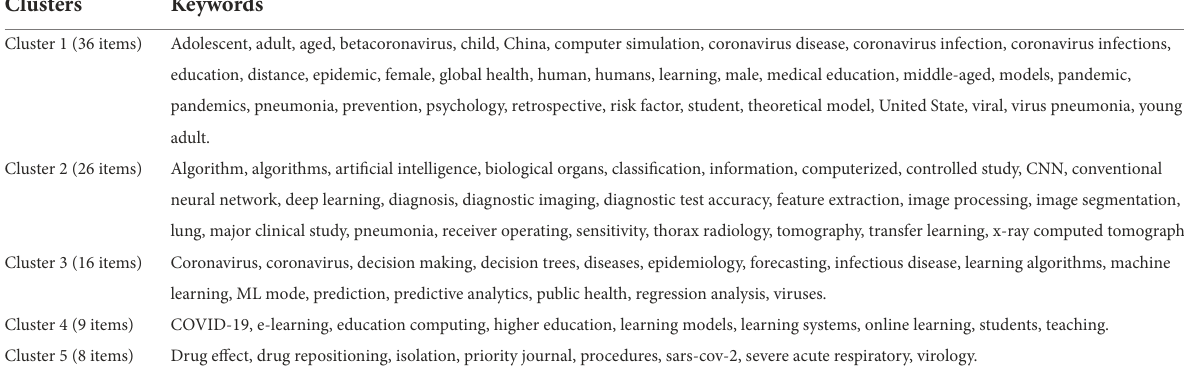
TABLE 2 Learning strategies and models in COVID-19 depending on Scopus (VOSviewer outputs).